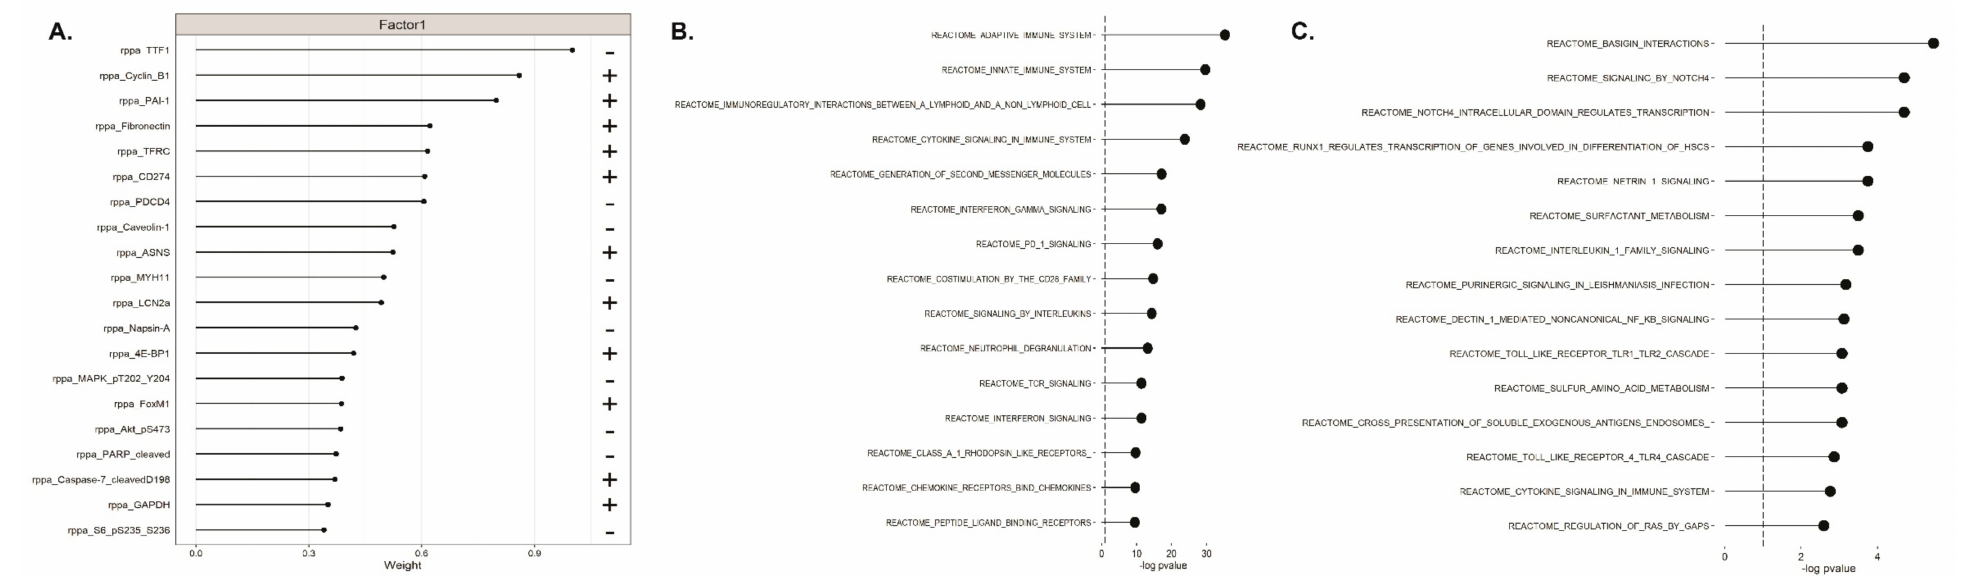
Figure 4. ( A ) Line plot displaying the absolute loading from the top 20 features of Factor 1 in the protein data. The corresponding weight sign is depicted on the right, scaled from − 1 to 1. Proteins with positive weights have higher levels of expression in the samples that have Factor 1 positive values, and vice-versa. ( B ) Visualization of the enrichment analysis results, running GSEA on Multi-Omics Factor Analysis (MOFA) factor 2 with gene expression negative weights and Reactome gene sets. ( C ) Visualization of the enrichment analysis results, running GSEA on MOFA factor 3 with copy number variation negative weights and Reactome gene